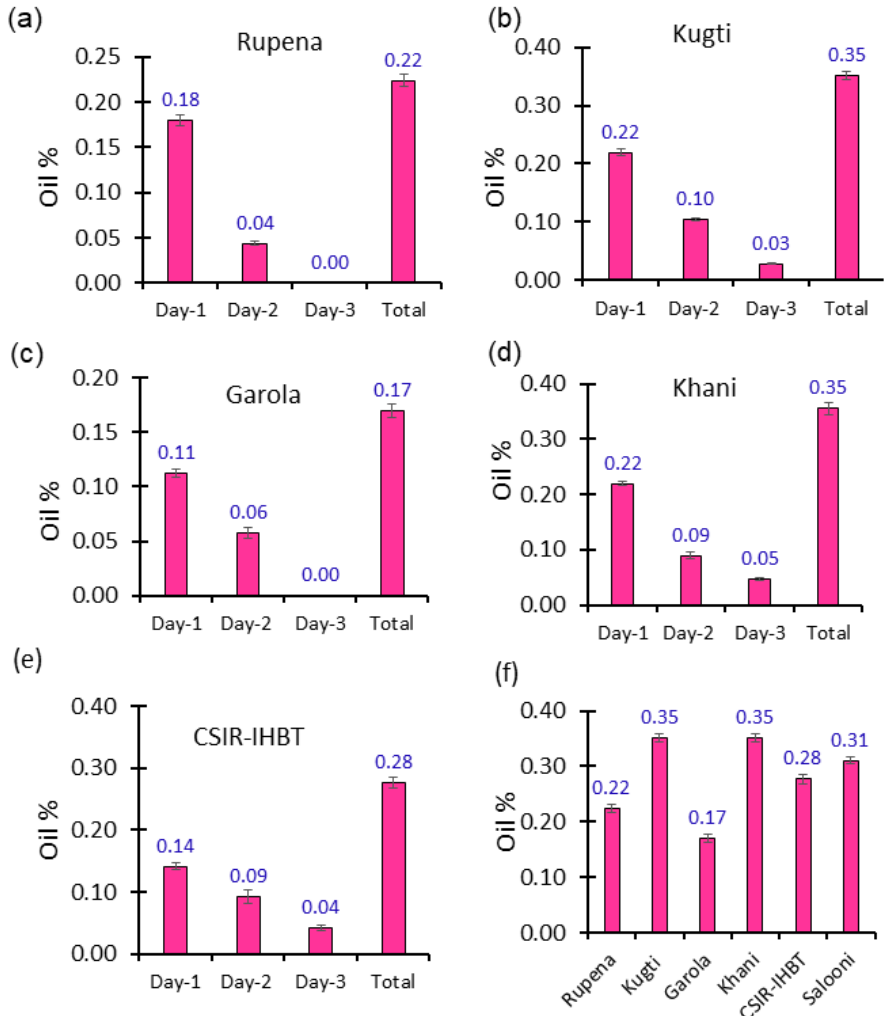
Figure 1. Concentration of essential oil (%) in the different populations of V. jatamansi collected from Rupena ( a ), Kugti ( b ), Garola ( c ), Khani ( d ), and CSIR-IHBT ( e ) during different distillation cycles, and total recovery of essential oil (%) of four wild populations (Rupena, Kugti, Garola, and Khani) and two cultivated sources of CSIR-IHBT and Salooni ( f ) under repetitive distillation method.